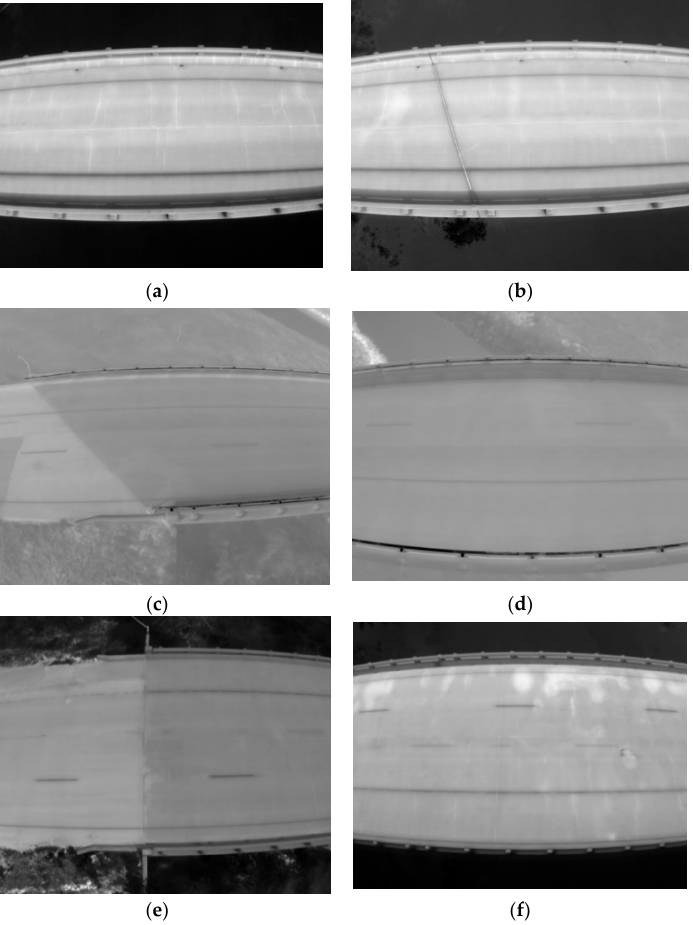
Figure 8. Samples of IRT images with ( a ) Excellent and ( b ) Good Brisque score; ( c ) Fair and ( d ) Poor Pique Scores ( e ) Poor natural or unnaturalness and ( f ) Excellent or good naturalness.